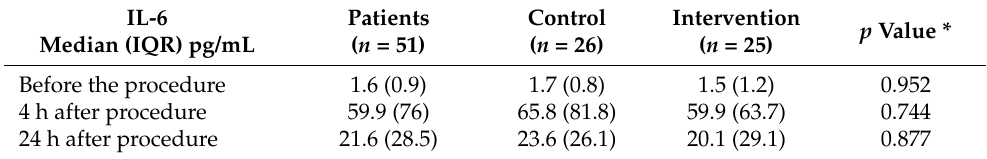
Table 3. IL-6 values. IL-6 = Interleukin 6; IQR = interquartile range; * Mann–Whitney test.